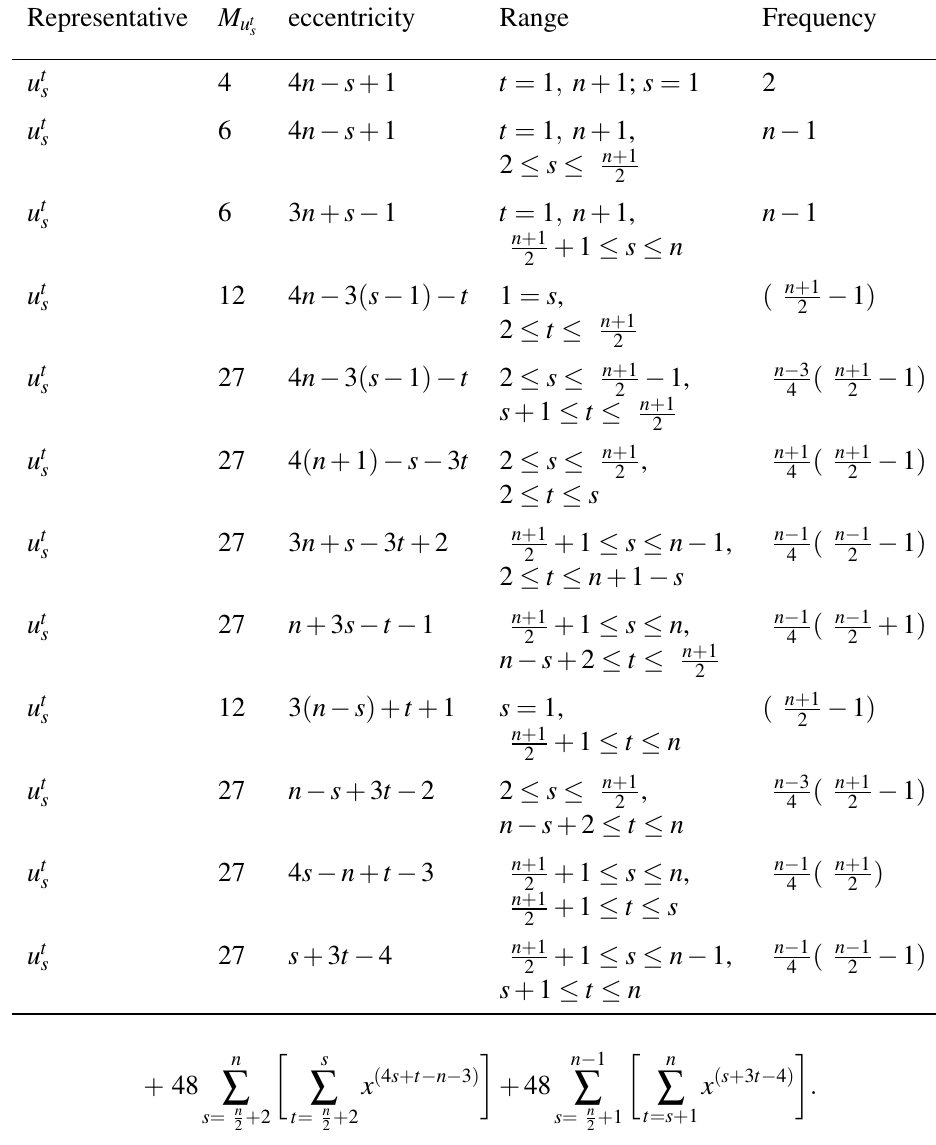
of O m based on degree product and eccentricity of each vertex when n ≡ 1 ( s n